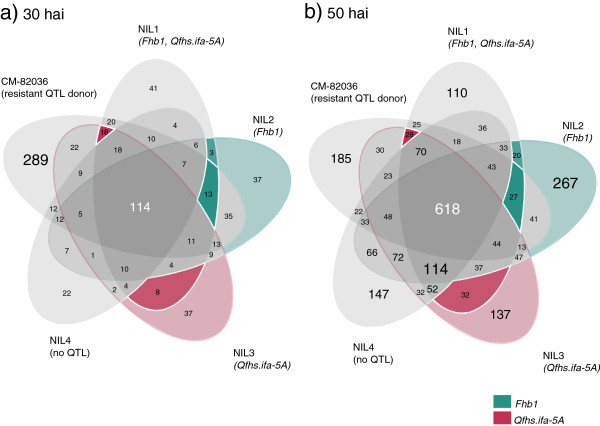
Differentially expressed genes per line. Venn diagrams showing unique F. graminearum responsive genes at 30 hours after inoculation (hai) (a) and 50 hai (b) for the investigated genotypes (CM-82036, NIL1 (harboring both resistance QTL, Fhb1 and Qfhs.ifa-5A), NIL2 (Fhb1), NIL3 (Qhfs.ifa-5A) and NIL4 (no QTL)) as well as genes shared between them in the respective intersections. Intersections of lines sharing either of the two QTL harbor genes associated with these QTL. These are highlighted in cyan (Fhb1) or magenta (Qfhs.ifa-5A).